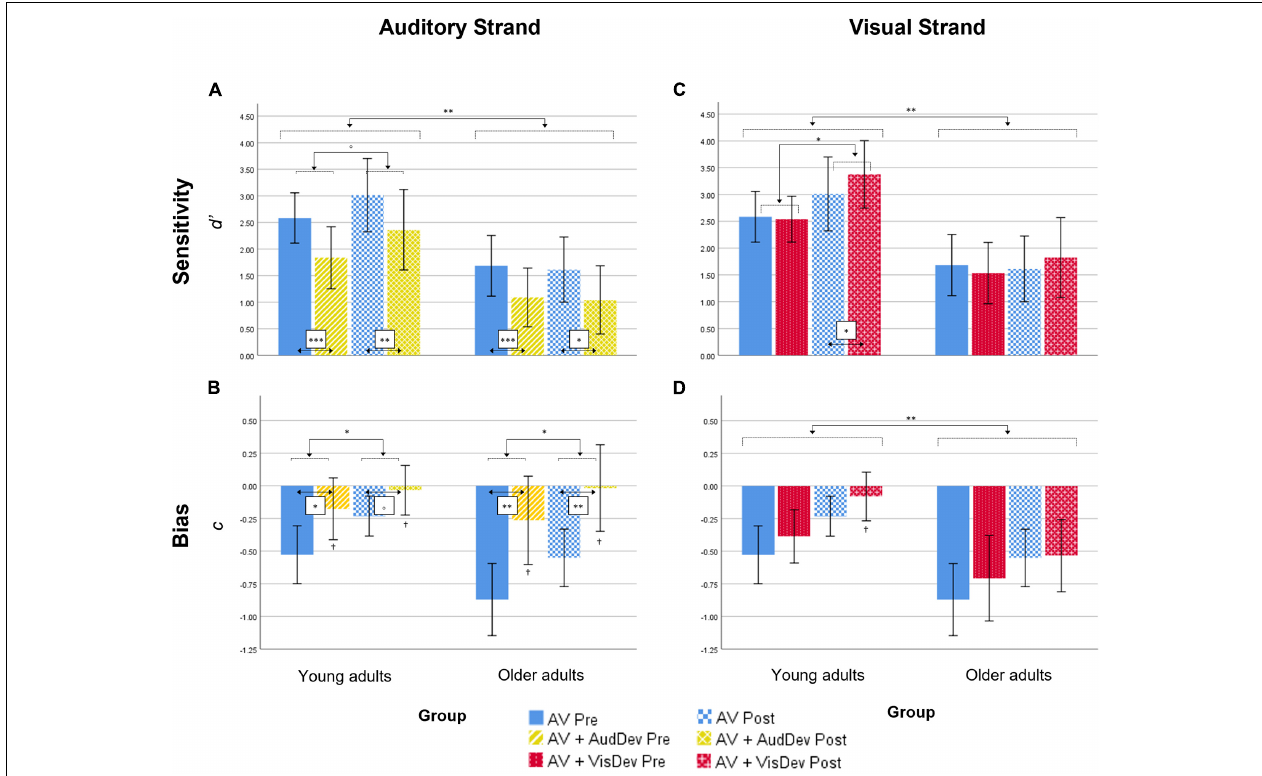
FIGURE 2 | Behavioral results for both the Auditory strand (left column) and the Visual strand (right column), for both measures Sensitivity (top row) and Bias (bottom row). In detail: results for the Sensitivity (A) and Bias (B) scores in the Auditory strand of the analysis, which compares the Audiovisual task condition to the Audiovisual task + Auditory deviance condition; results for the Sensitivity (C) and Bias (D) scores in the Visual strand of the analysis, which compares the Audiovisual task condition to the Audiovisual task + Visual deviance condition. AV, score for the main audiovisual task without distractors; AV + AudDev, score for the main audiovisual task in the presence of the auditory distractor; AV + VisDev, score for the main audiovisual task in the presence of the visual distractor; Pre, before training; Post, after training. ◦ p < 0.1; * p < 0.05; ** p < 0.01; *** p = 0.001; † non-significant bias (one-sample test against 0, p = 0.002). Error bars show 95%